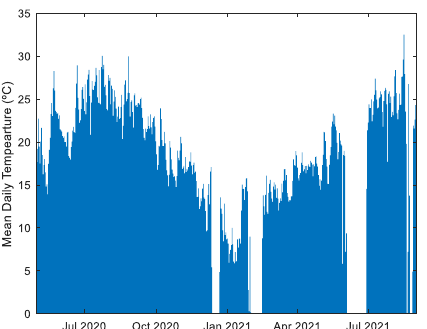
Figure 6. Mean daily temperature.